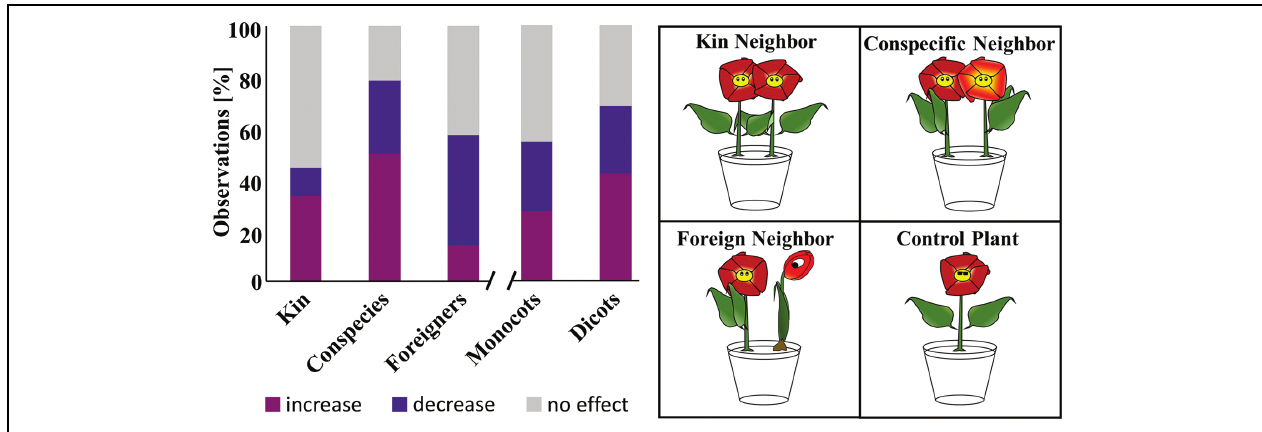
FIGURE 6 | Influence of a neighboring plant on root development. Data presented in a bar chart summarizes the observations of several studies which compared root development of a plant with and without neighbor. The cartoon on the right illustrates the interactions considered here. “Increase, decrease, no effect” refer to the root biomass of a plant with neighbor compared to the one without. Kin: 20 observations in which interacting plants are kins. Conspecies: 27 observations where tested plants are from the same species (but not kins). Foreign: 45 observations where interacting plants belong to different species. Monocots: 28 observations involving monocotyledonous plants. Dicot: 64 observations involving dicotyledonous